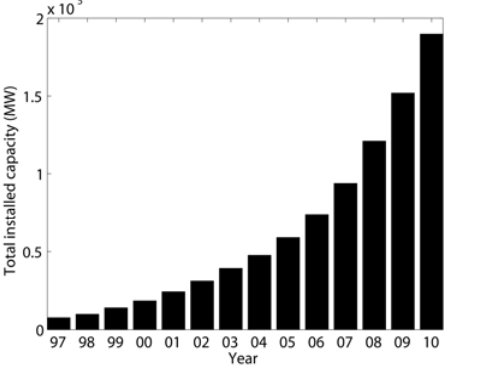
Figure 1 . World wide total installed capacity (MW) and prediction from 1997 to 2010 reported by